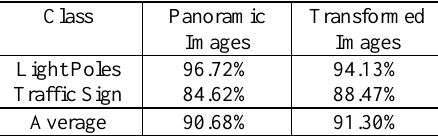
Table 2. Accuracy of the results from